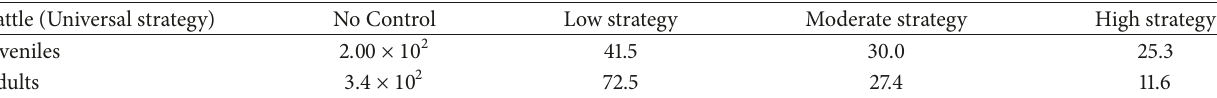
Table 6: Simulation results of the cumulative number of new cases at 𝑡 = 250 days for the juvenile and adult cattle using the universal-control